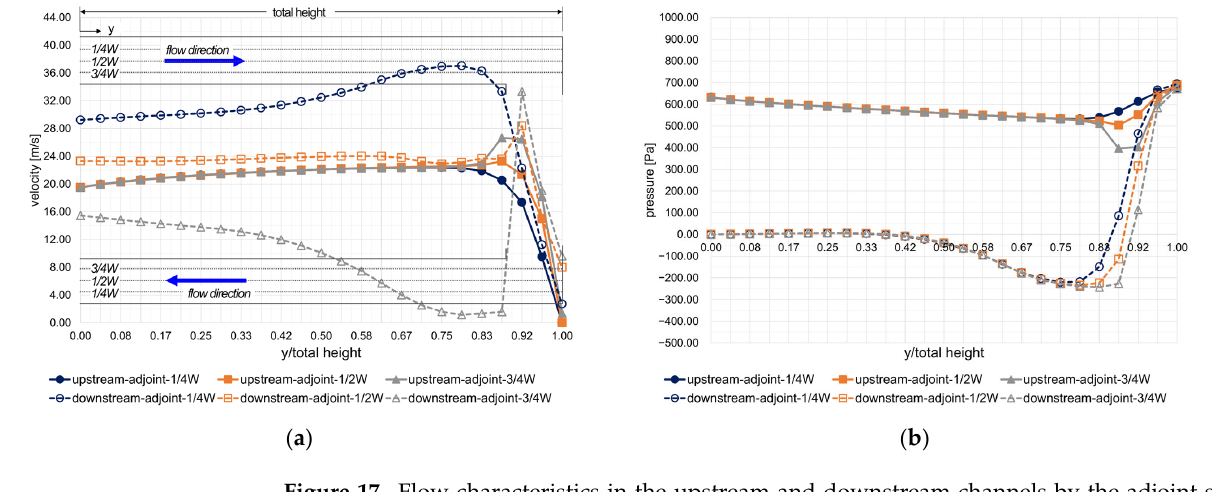
Figure 17. Flow characteristics in the upstream and downstream channels by the adjoint solver (Re = 24,230): ( a ) velocity distribution; ( b ) pressure distribution.